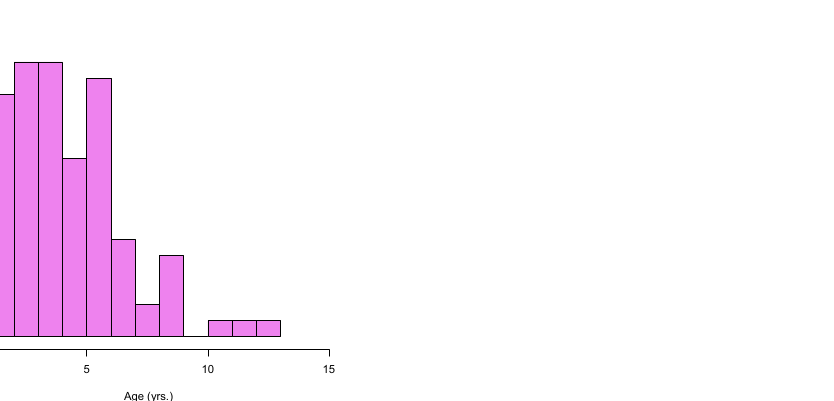
Age (yrs.) Figure 2. Histogram representing age distribution of new cases detected in cattle from dairy farms in Southern Chile.